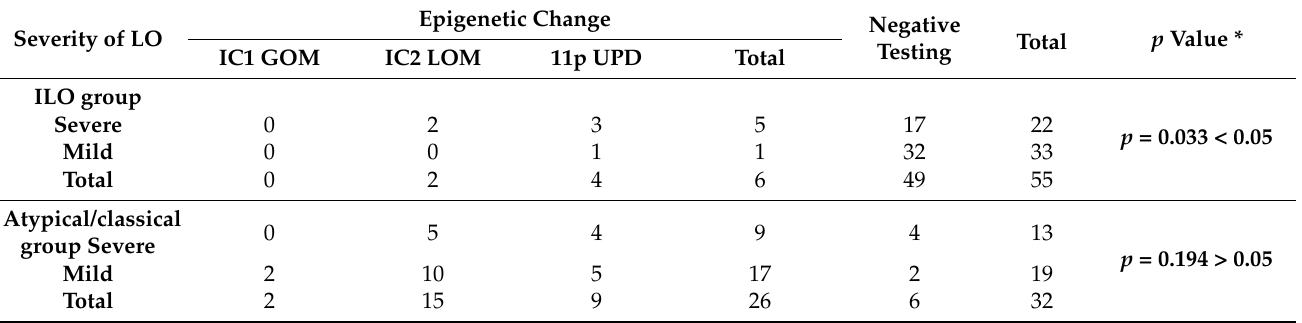
Table 3. The relationship between epigenetic alteration in region 11p15.5 and the severity of lateral- ized